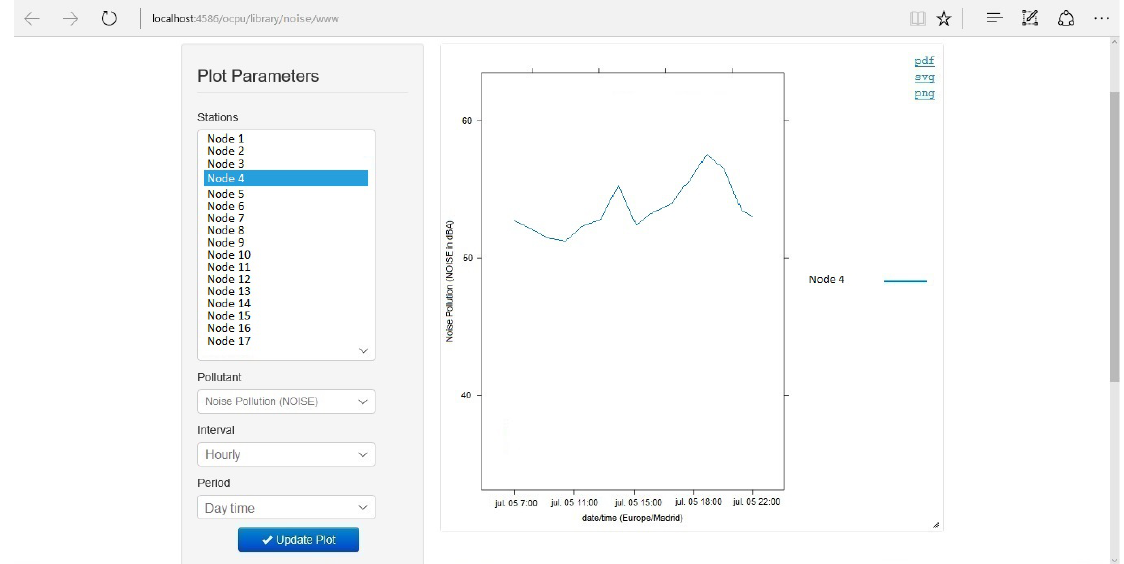
Figure 2. OpenCPU framework to gather the noise pollution